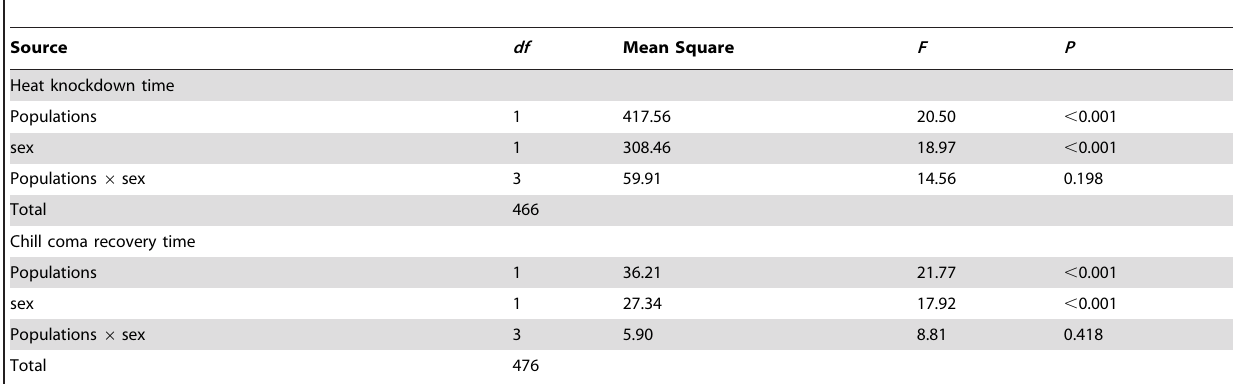
Table 2. ANOVA table of heat knockdown time and chill coma recovery time of B. tabaci MED cryptic species.